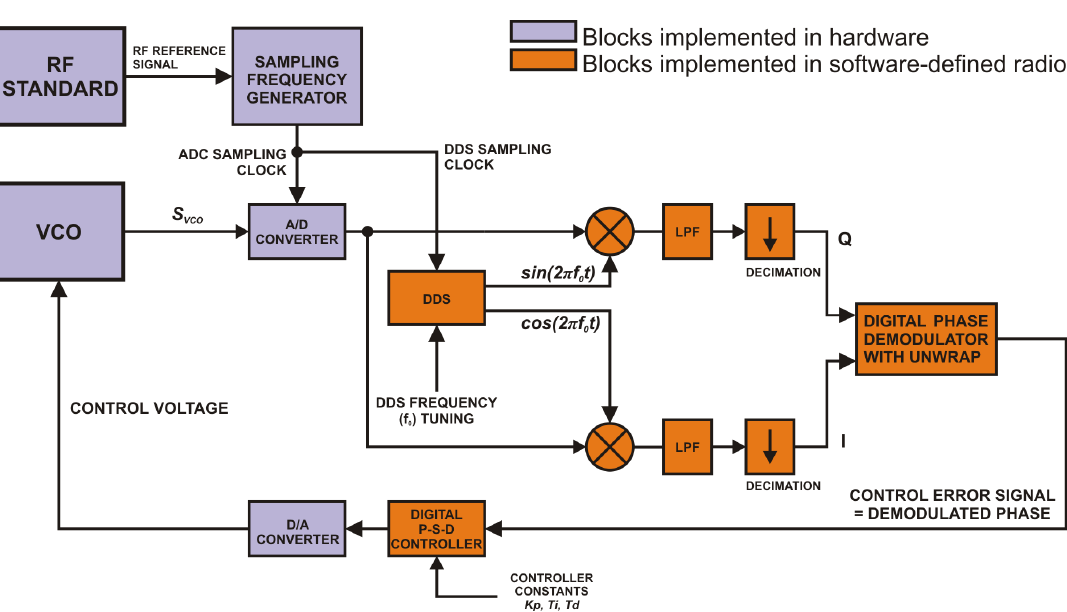
Figure 1. The block schematics of the software-defined radio system for digital phase locking: VCO is a voltage controlled oscillator as the example of the controlled system; LPF is the digital low pass filter; A/D and D/A converters are analog-to-digital and digital-to-analog converters, respectively; RF standard is a high-grade harmonic oscillator with ultimate stability of generated frequency; DDS is the direct-digital